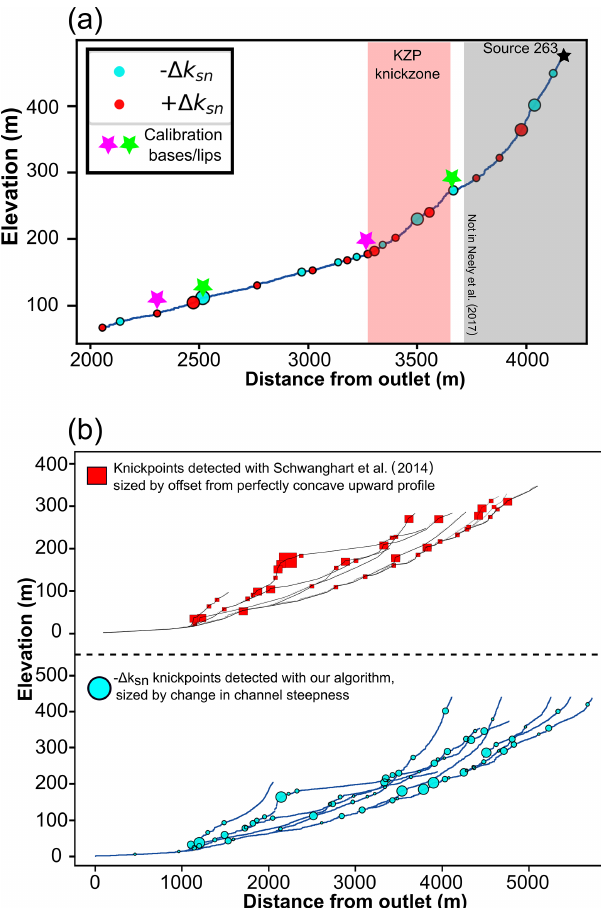
Figure 11. Comparison of results from the Smugglers catchment for our algorithm and the most recent similar ones. (a) Results for a single source from KZ-Picker (Neely et al., 2017) and our results. The results from Neely et al. (2017) are directly taken from their study to ensure objectivity. Only the slope-break knickpoints are displayed to make the comparison valid. (b) Basin-wide comparison between our algorithm outputs and the one recently implemented in Schwanghart and Scherler (2014) using a tolerance of 5. We only display the knickpoints showing a decrease in k sn in order to provide a relevant comparison with the knickpoint morphology detected by Schwanghart and Scherler (2014). Differences in channel length are due to different methods for extracting channel heads between the two